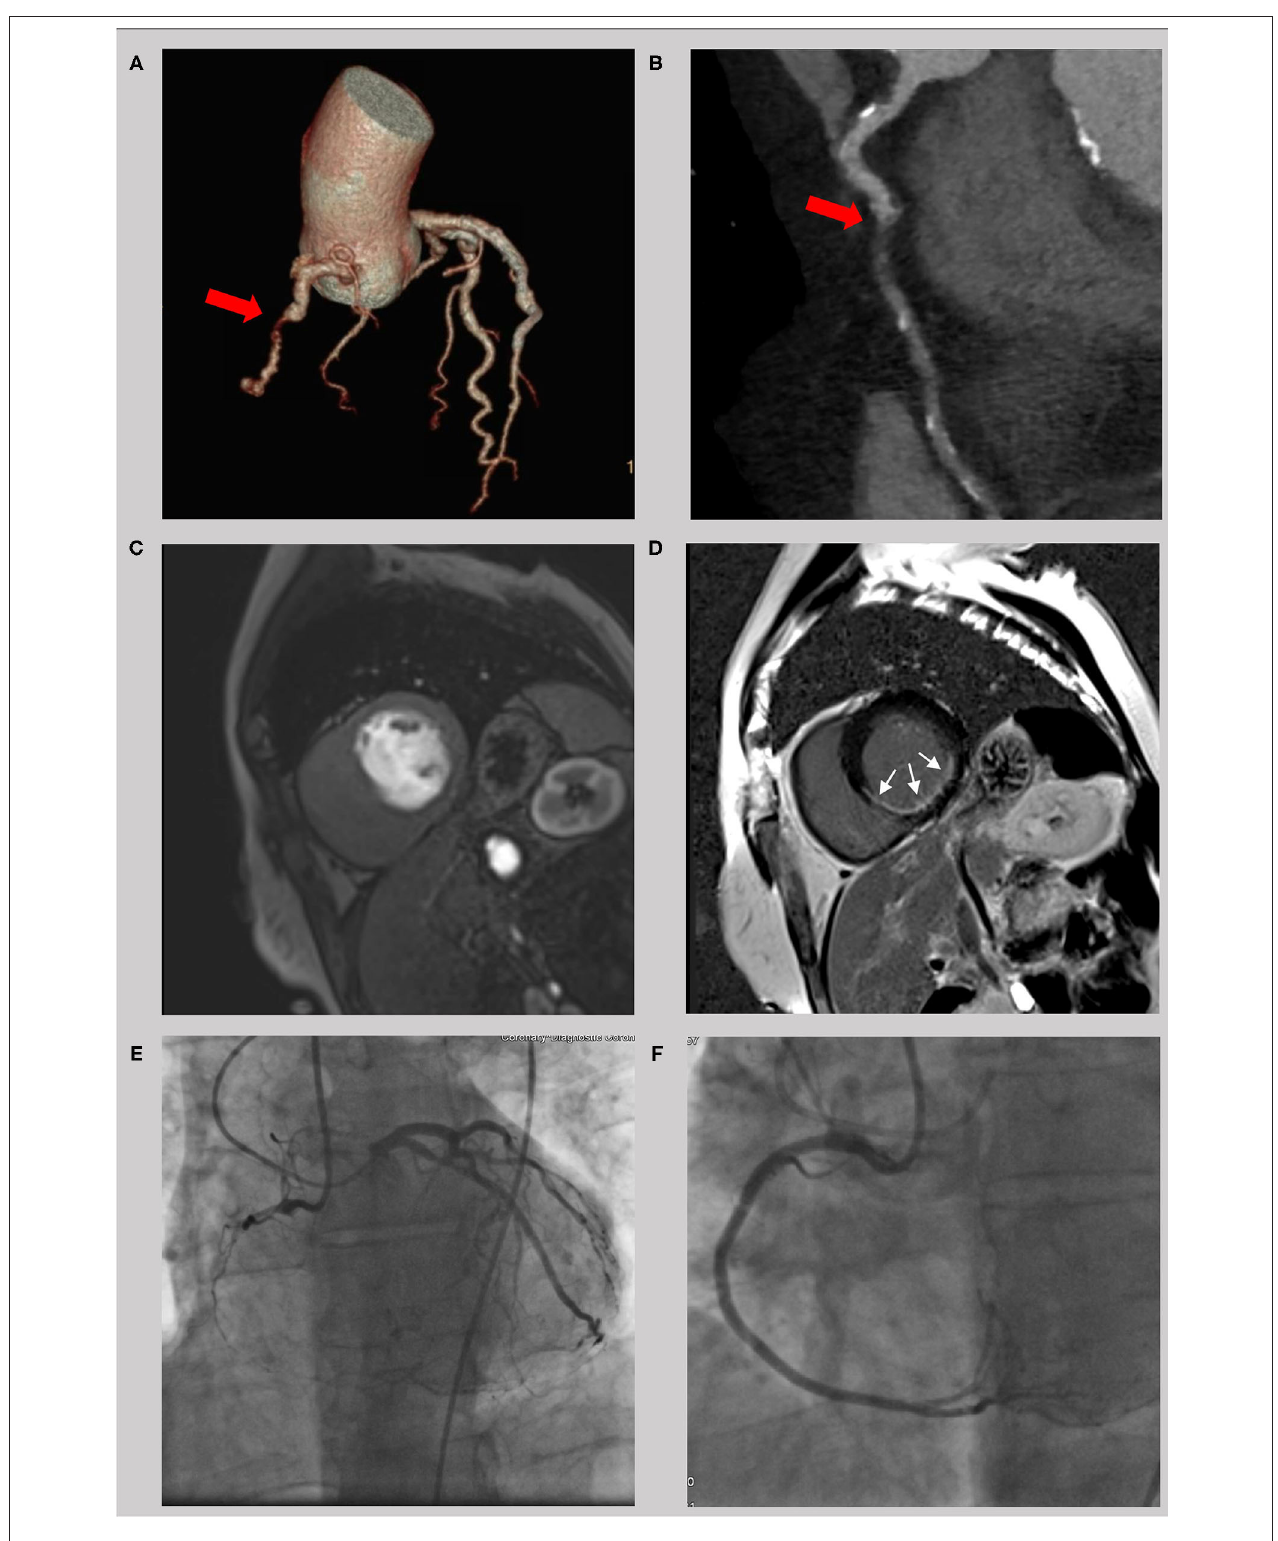
FIGURE 3 | Example of a 56 year old male with a chronic total occlusion of the right coronary artery. The occlusion is seen in the computer tomography coronary angiogram ( A and B , red cross) with a short occlusion length and a small amount of calcification. Because of an impaired regional function with thinning of the left ventricular wall, imaging of ischemia ( C , first-pass perfusion) and scarring ( D , late gadolinium enhancement) was done using cardiac magnetic resonance. With a LGE of < 50% transmurality (white crosses) and a high symptom burden, interventional revascularization was successfully performed (E,F) with significant clinical